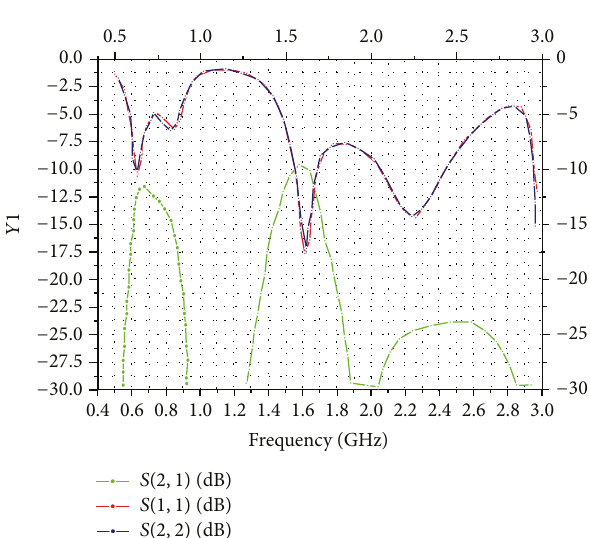
Figure 7: Double antenna structure diagram.